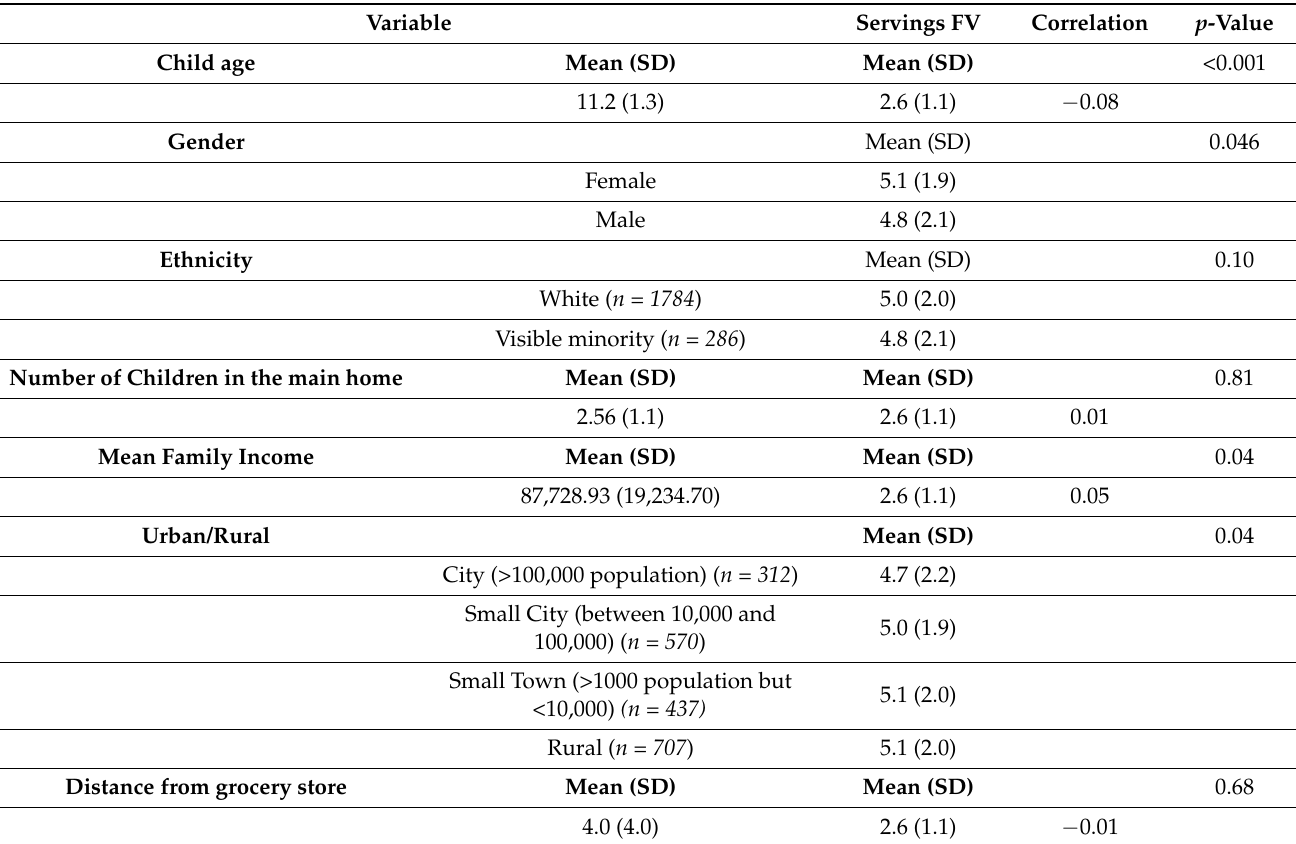
Table 3. Associations between participant sociodemographic variables and servings of fruits and vegetables